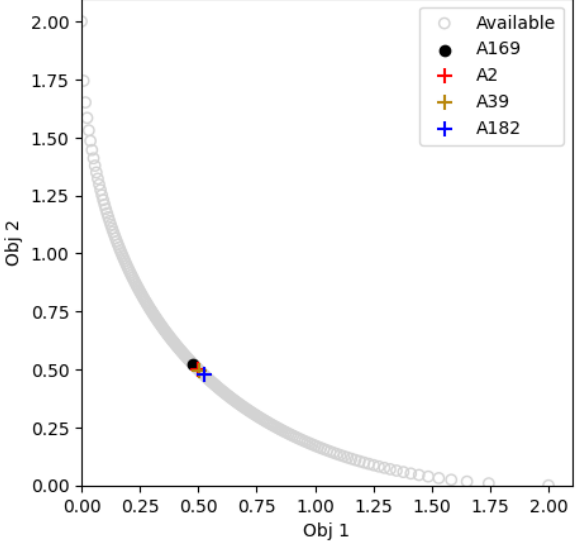
Figure 8. Best solutions for the PF1 based on the AHP and the proposed